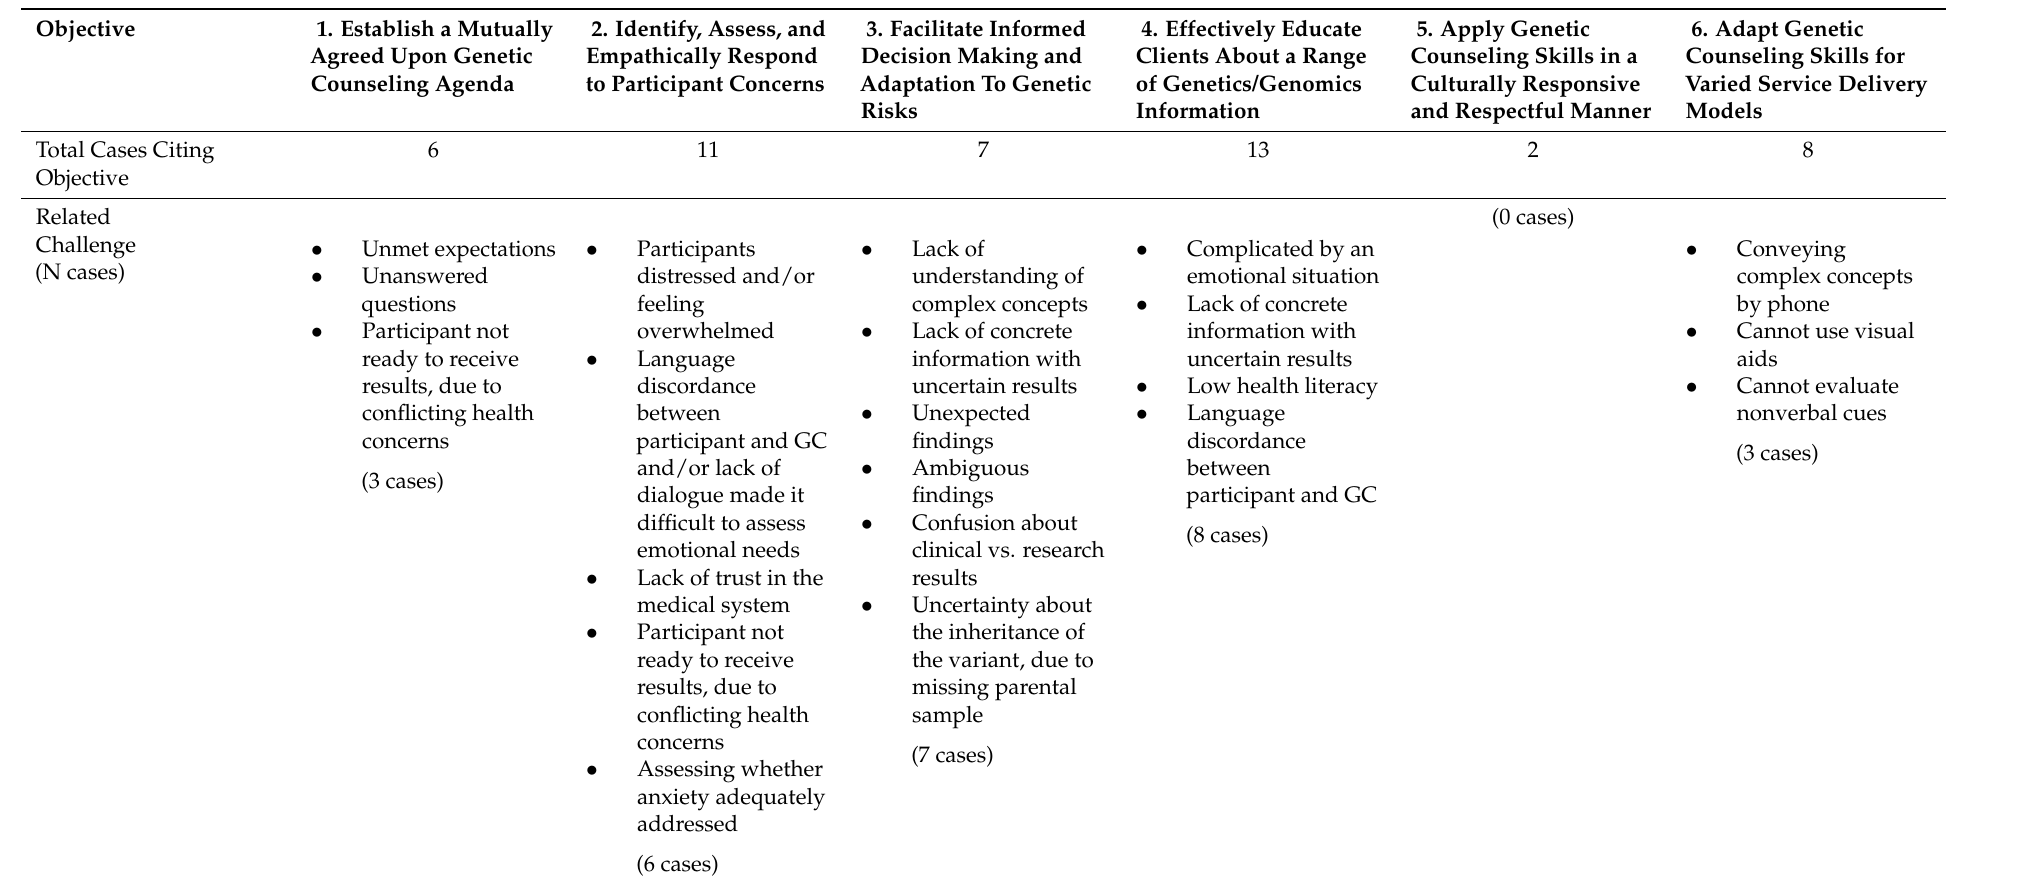
Table 2. Case challenges and strategies for each result disclosure